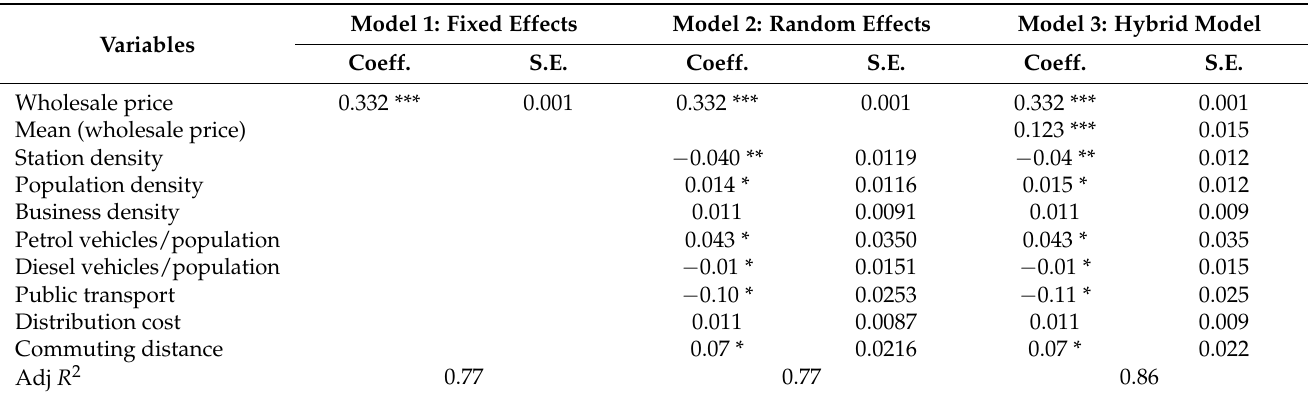
Table 9. Determinants that influenced the retail petrol price at a city level when considering the crude oil price as a proxy for the upstream